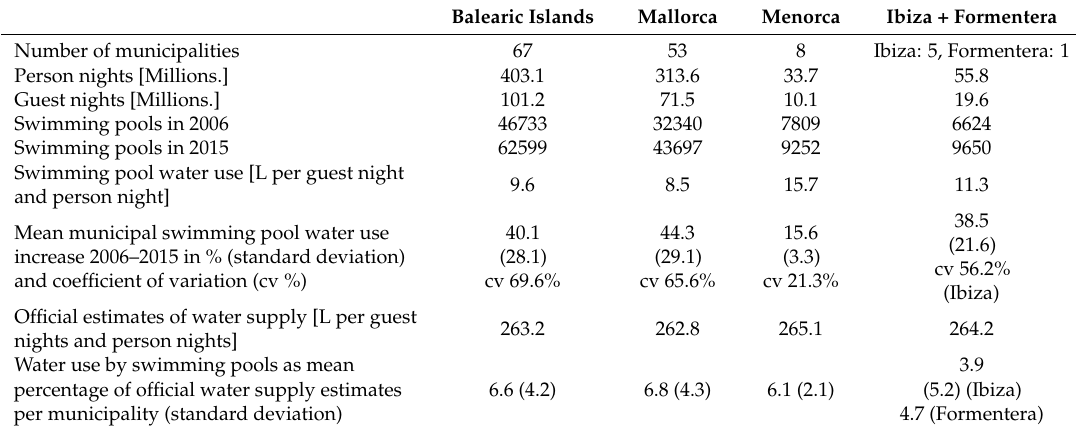
Table 2. Swimming pool water use indicators for the year 2015. Data source: swimming pool